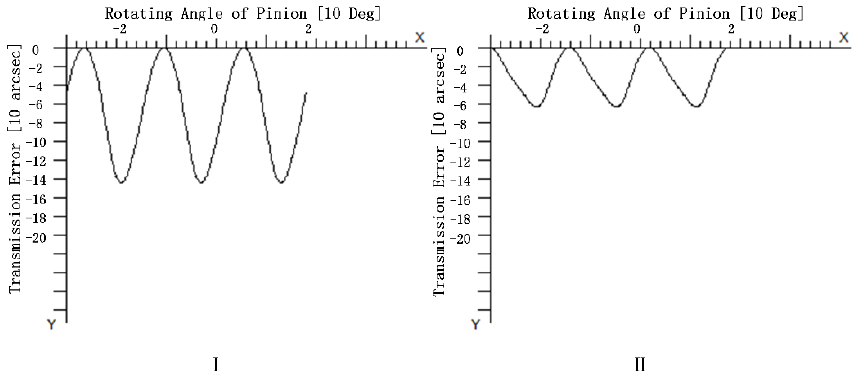
Figure 16. LTE curves at a load of 400 N·m: ( I ) Unmodified; ( II ) Modification.